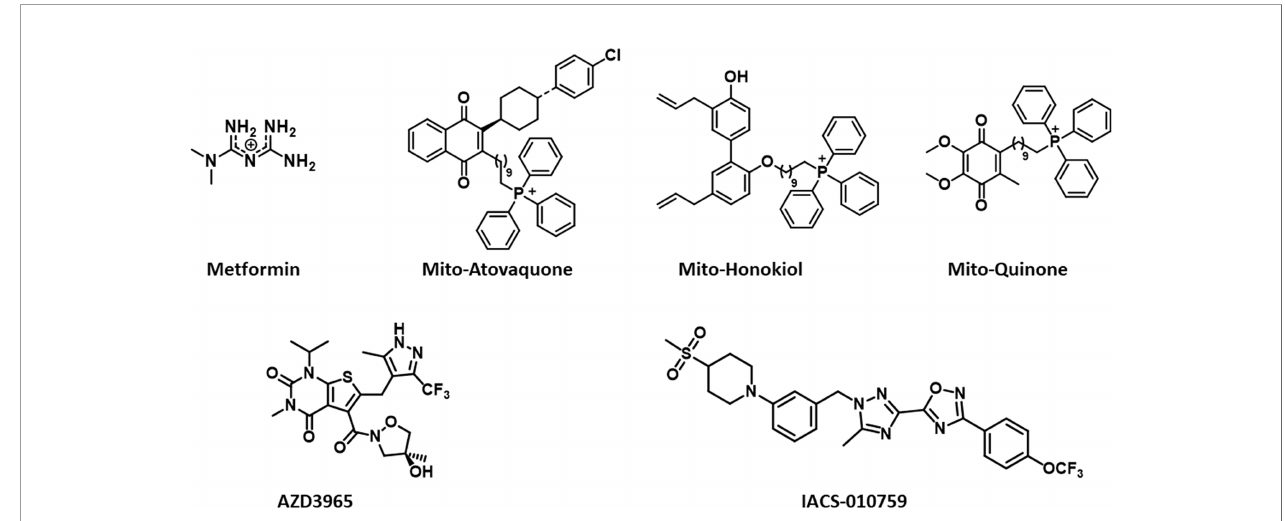
FIGURE 2 | Structures of mitochondria-targeted natural products, a co-enzyme, and